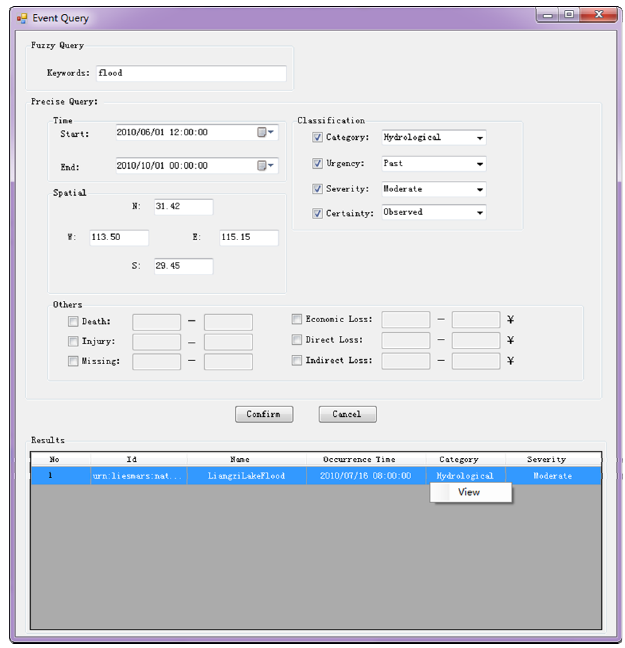
Figure 10. Query result when inputting the space-time information of LZ